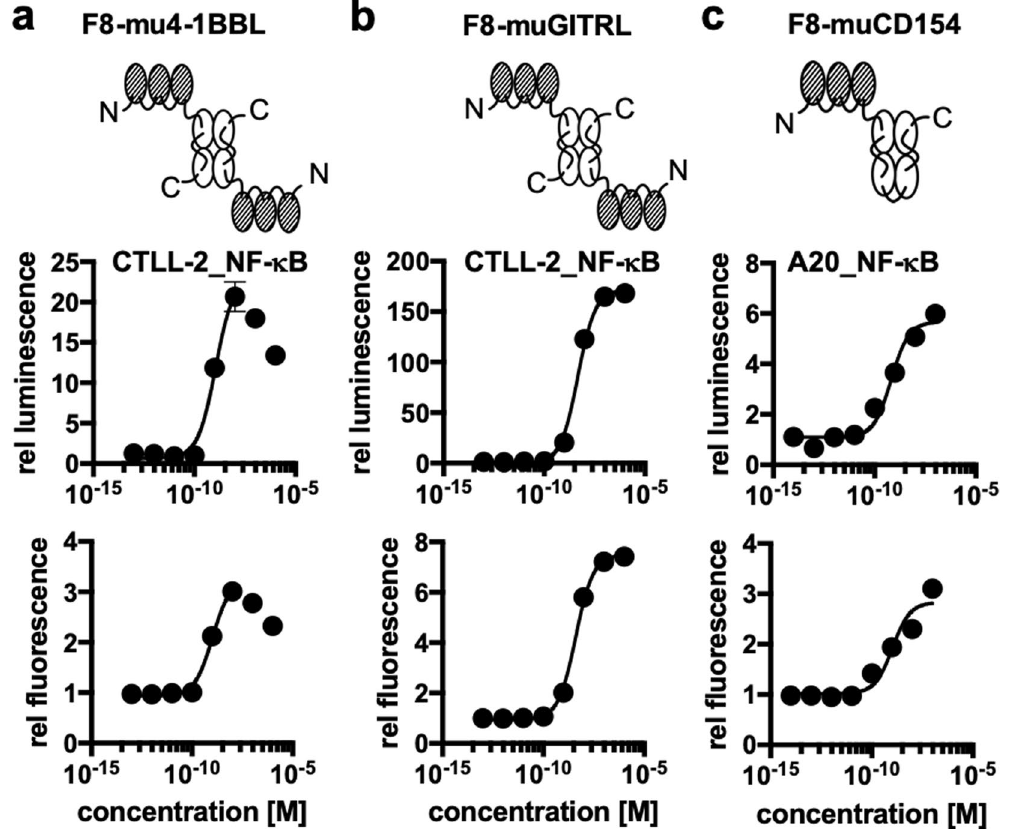
Figure 3. Activity tests of novel antibody-cytokine conjugates using the newly developed reporter cell lines [a] activity tests of the single chain trimeric 4-1BBL fused to the F8 antibody in the diabody format using the CTLL-2 reporter cell line [b] activity of single chain trimeric GITRL fused to the F8 antibody in the diabody format using the CTLL-2 reporter cell line [c] activity of single-chain trimeric CD154 fused to the F8